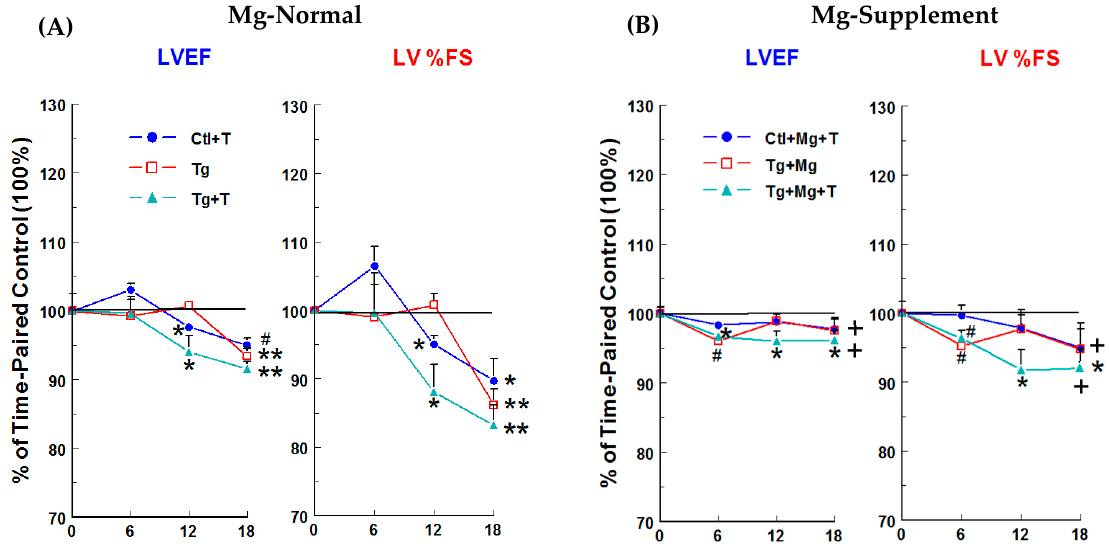
Figure 4. Temporal effects of HIV-1 expression ± cART (T) on LV systolic function of Mg-normal ( A ) and Mg-supplemented ( B ) rats. LV ejection fraction (LVEF) and % fractional shortening (%FS) were monitored by echocardiography for 18 weeks. Values are means ± SE = 5 rats/group. * p < 0.05, # p < 0.02, ** p < 0.01 vs. Ctl (100%); + p <0.05 vs. Mg-normal counterparts.